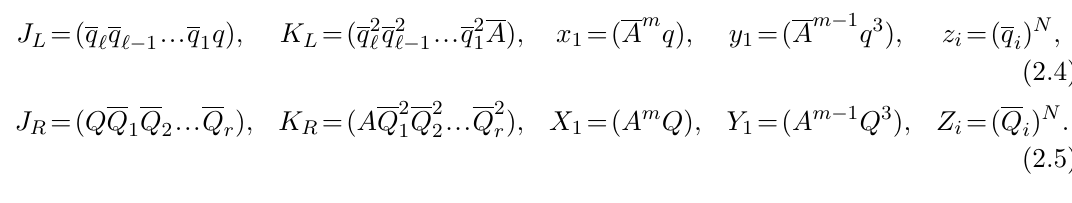
SU( N ) R U(1) 4 , and the approximate U(1) PQ (cid:2) (cid:2)